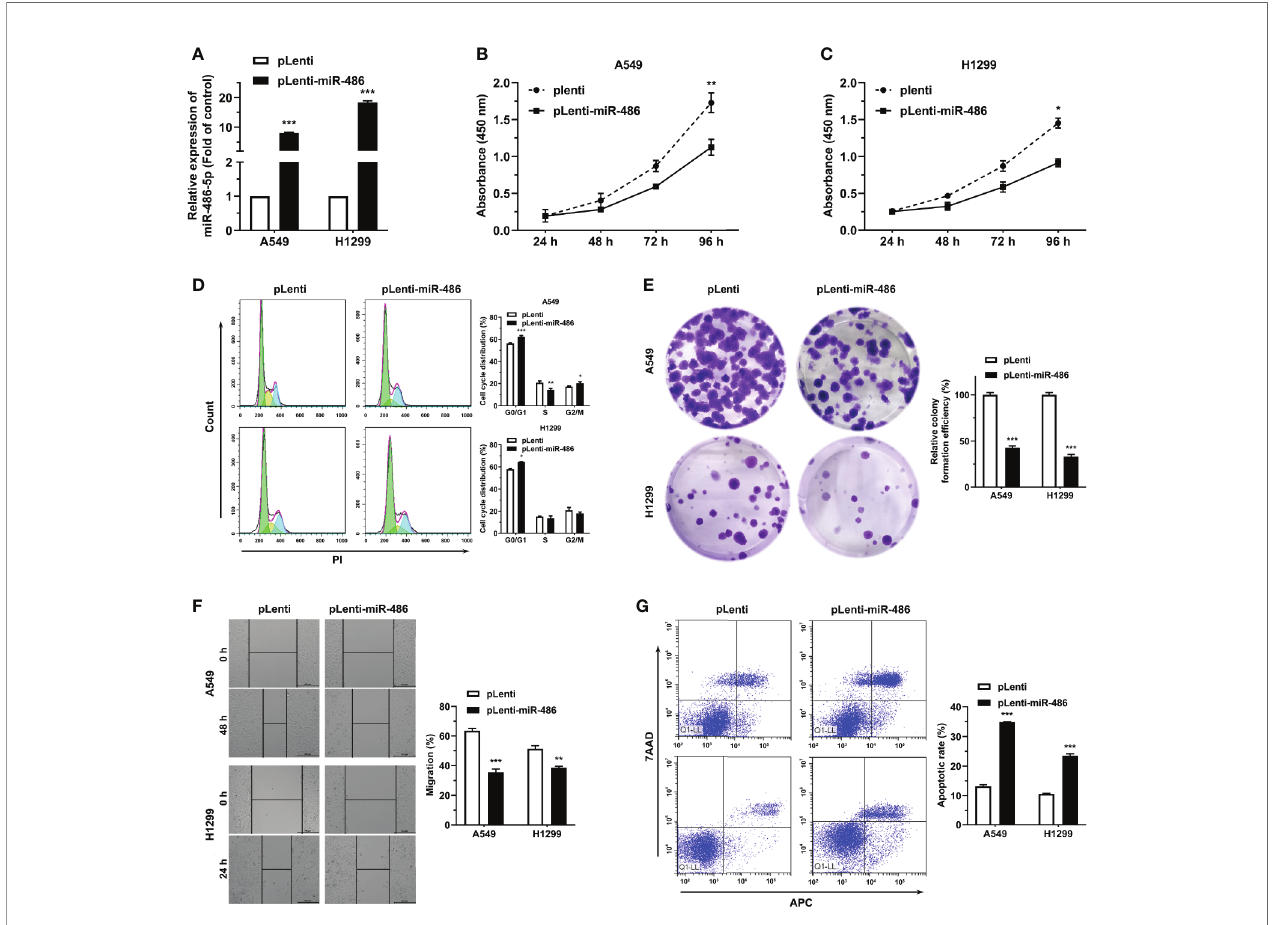
FIGURE 2 | miR-486-5p suppresses the proliferation and migration of NSCLC cells and promotes cell apoptosis. (A) The expression of miR-486-5p in pLenti/ pLenti-miR-486 stably transfected A549 and H1299 cells. ***p < 0.001. (B – G) The effect of miR-486-5p on the proliferation (B, C) , cell cycle progress (D) , colony formation (E) , migration (F) and apoptosis (G) of A549 and H1299 cells stably transfected with pLenti or pLenti-miR-486. *p < 0.05; **p < 0.01; ***p <